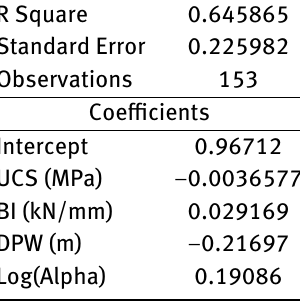
Table 4: Linear regression model with log(Alpha).